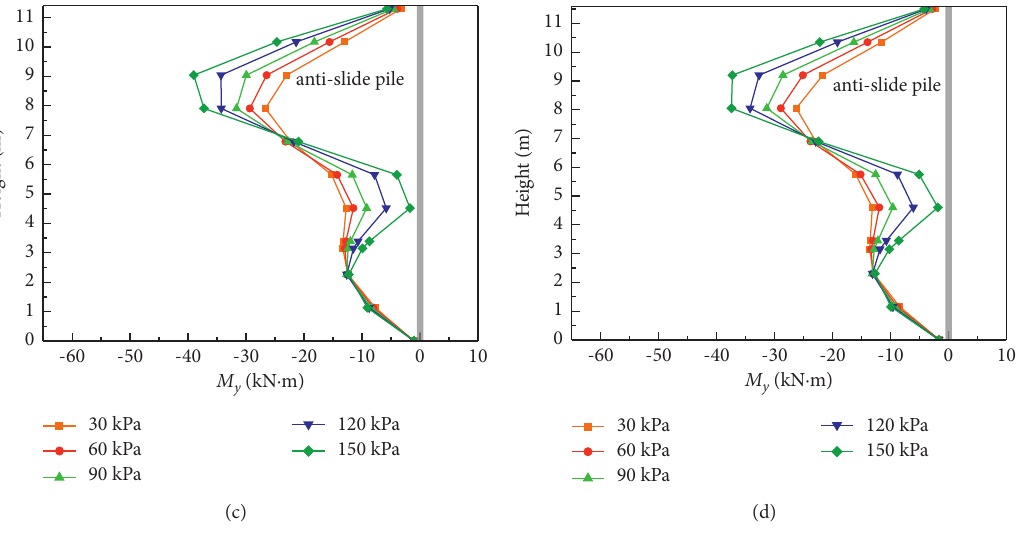
Figure 8: M y (3-16): (a) P1; (b) P3; (c) P5; (d) P6.